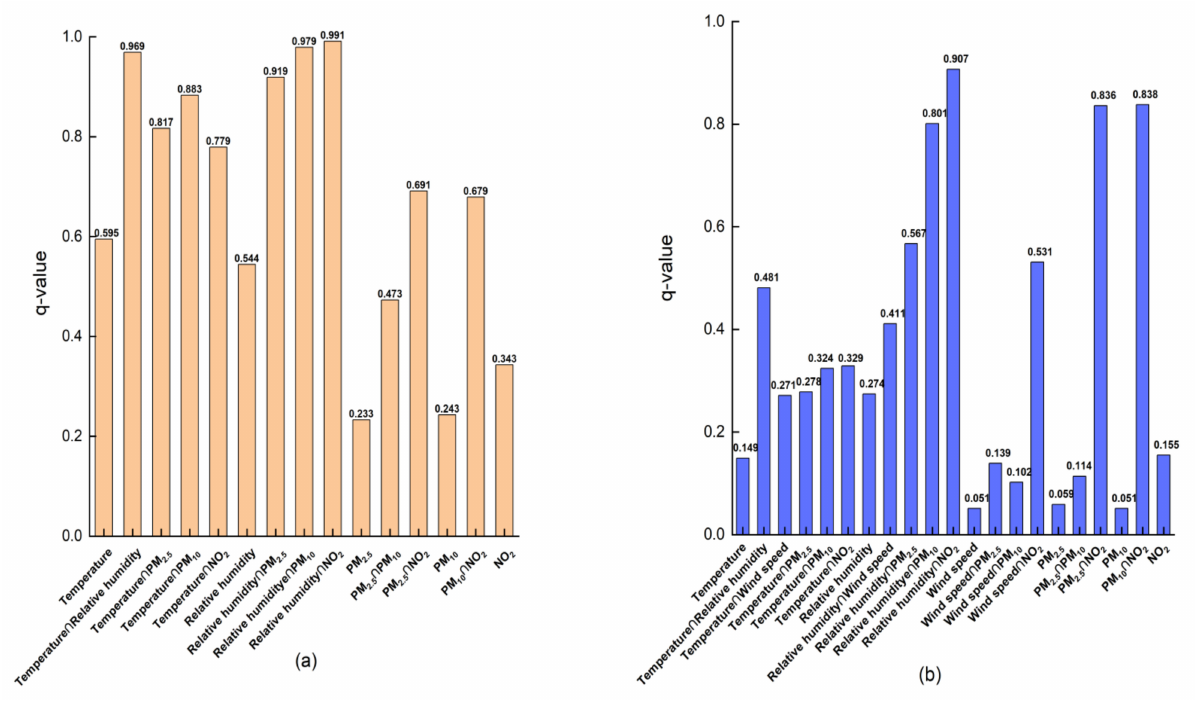
Figure 11. Power of determinants in interaction in northern cities ( a ) and southern cities ( b ). From the perspective of factor interaction, as shown in Table 3, there are two types of COVID-19 epidemic in northern cities: one was nonlinear enhancement and two was a bilinear enhancement. In addition, the interaction of all two factors was stronger than that of a single factor. For example, the q value of the interaction between relative humidity and NO 2 on the change in COVID-19 incidence rates was 0.991, which had the strongest influence on the COVID-19 incidence rates. Moreover, the interaction between relative humidity and all other influencing factors had a significantly greater effect on the COVID-19 incidence rates than the single effect of relative humidity on the COVID-19 incidence rates (0.544). In addition, compared with other factors, PM 2.5 had the smallest contribution to the COVID-19 incidence rates, the interaction type with temperature and PM 10 was a bilinear enhancement, and the interaction with other influencing factors had a non-linear synergistic effect on the COVID-19 incidence rates. Compared with the interaction of other factors, the q values of the average temperature, PM 2.5 , PM 10 , and NO 2 interacting with relative humidity significantly increased, being 0.969, 0.919, 0.979, and 0.991, respectively. In southern cities, a factor detector was used to determine the impact of each influ- encing factor on the change in COVID-19 incidence rates. It can be seen from Figure 11b that the q value range of all impact factors was 0.051~0.907, and the magnitude of the significant difference was as follows: relative humidity (0.274) > NO 2 (0.155) >